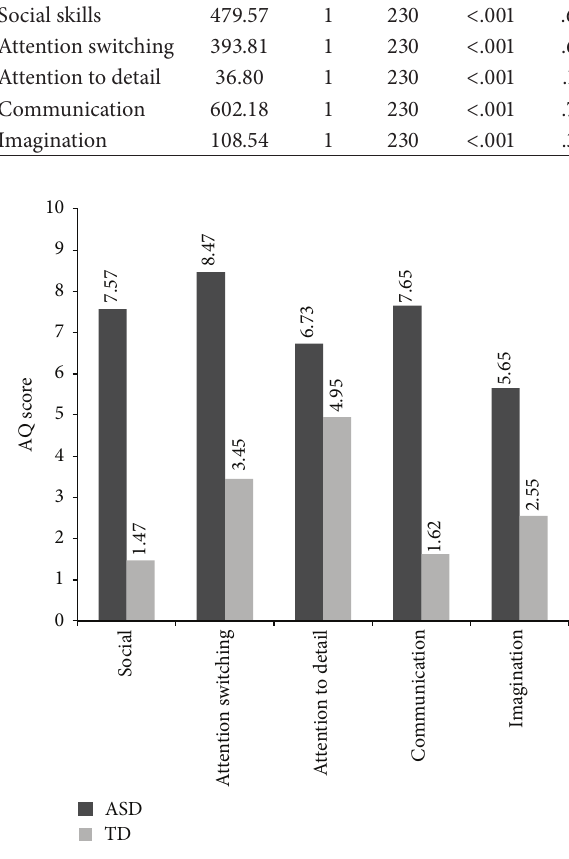
Figure 2: Distribution of scores for the AQ subscales social skills, attention switching, attention to Detail, communication, and imagination.